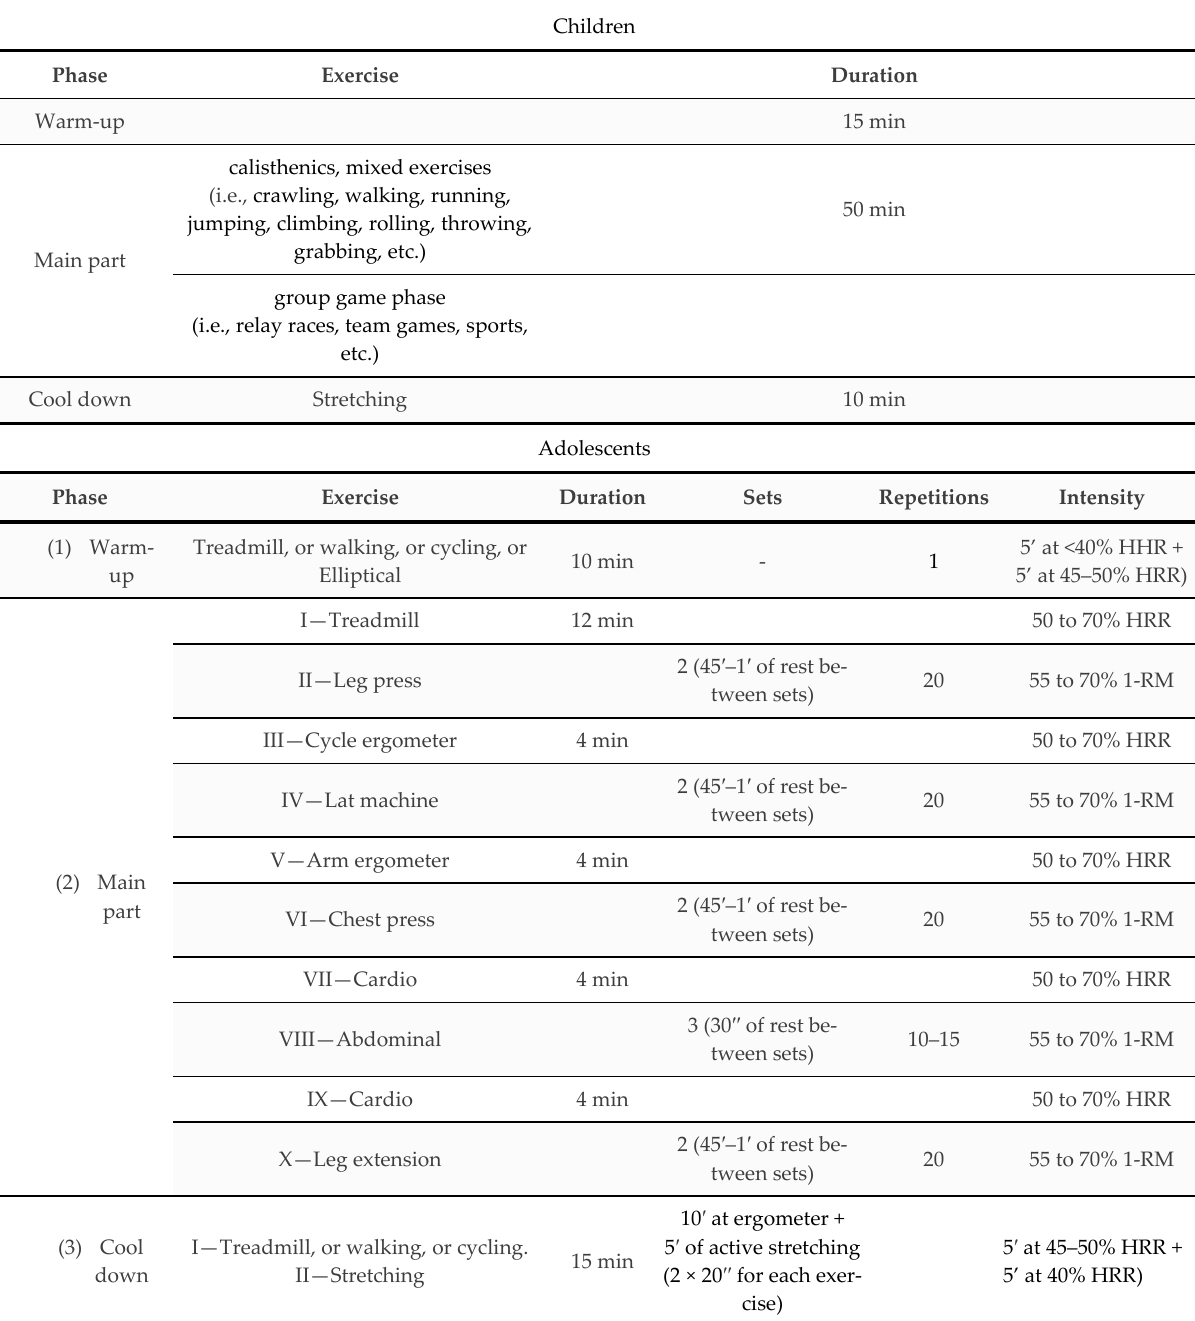
Figure 2. Examples of exercises for both children and adolescents’ intervention.